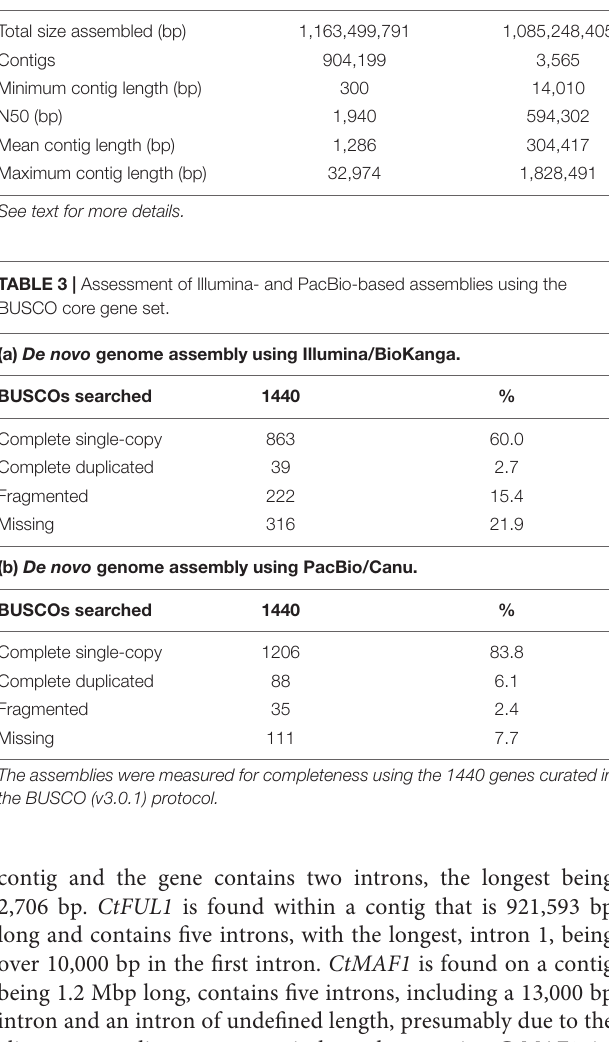
TABLE 2 | Summary statistics for the de novo assemblies of safflower S317 using two different sequencing and software combinations. Platform/assembler